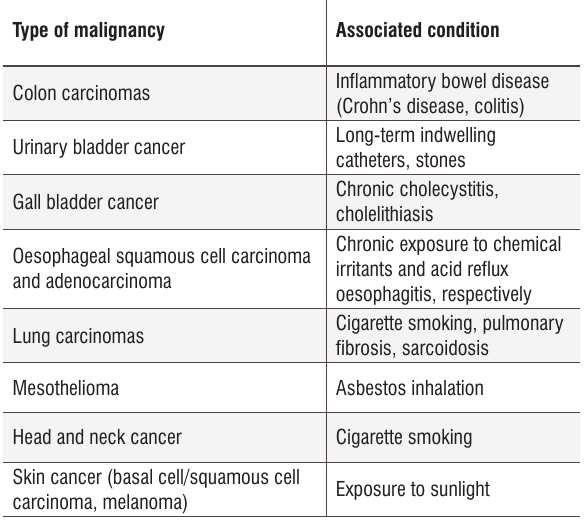
Examples of inflammation-related malignancies of chronic non- infective